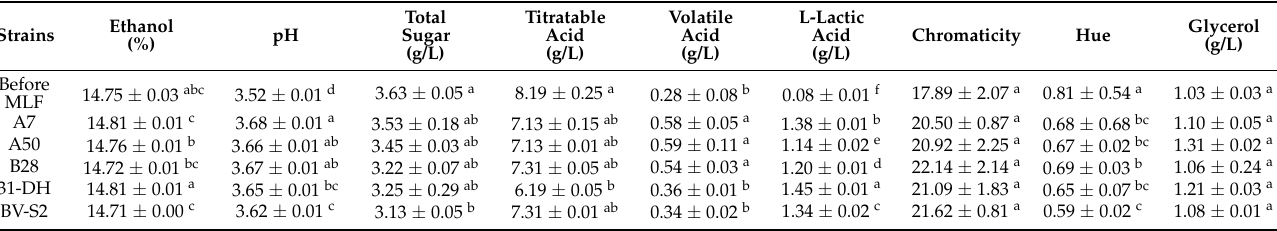
Table 5. Basic chemical parameters of cabernet sauvignon wines.